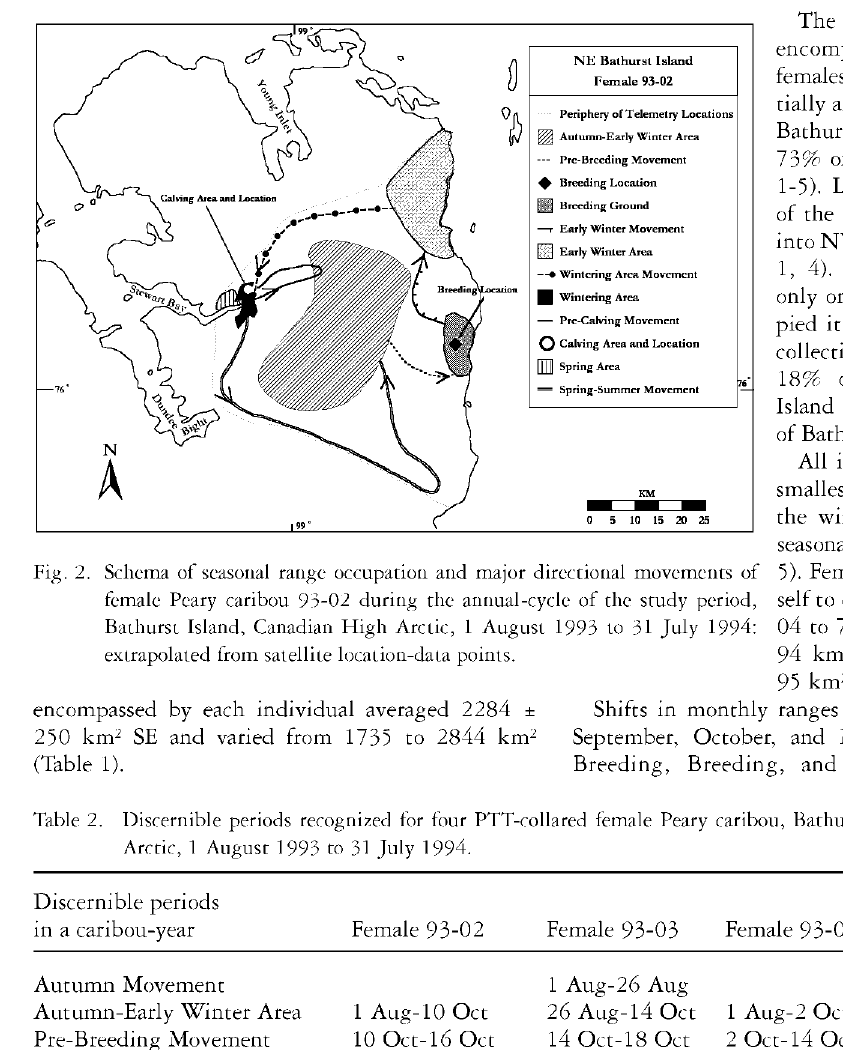
Table 2. Discernible periods recognized for four PTT-collared female Peary caribou, Bathurst Island, Canadian High